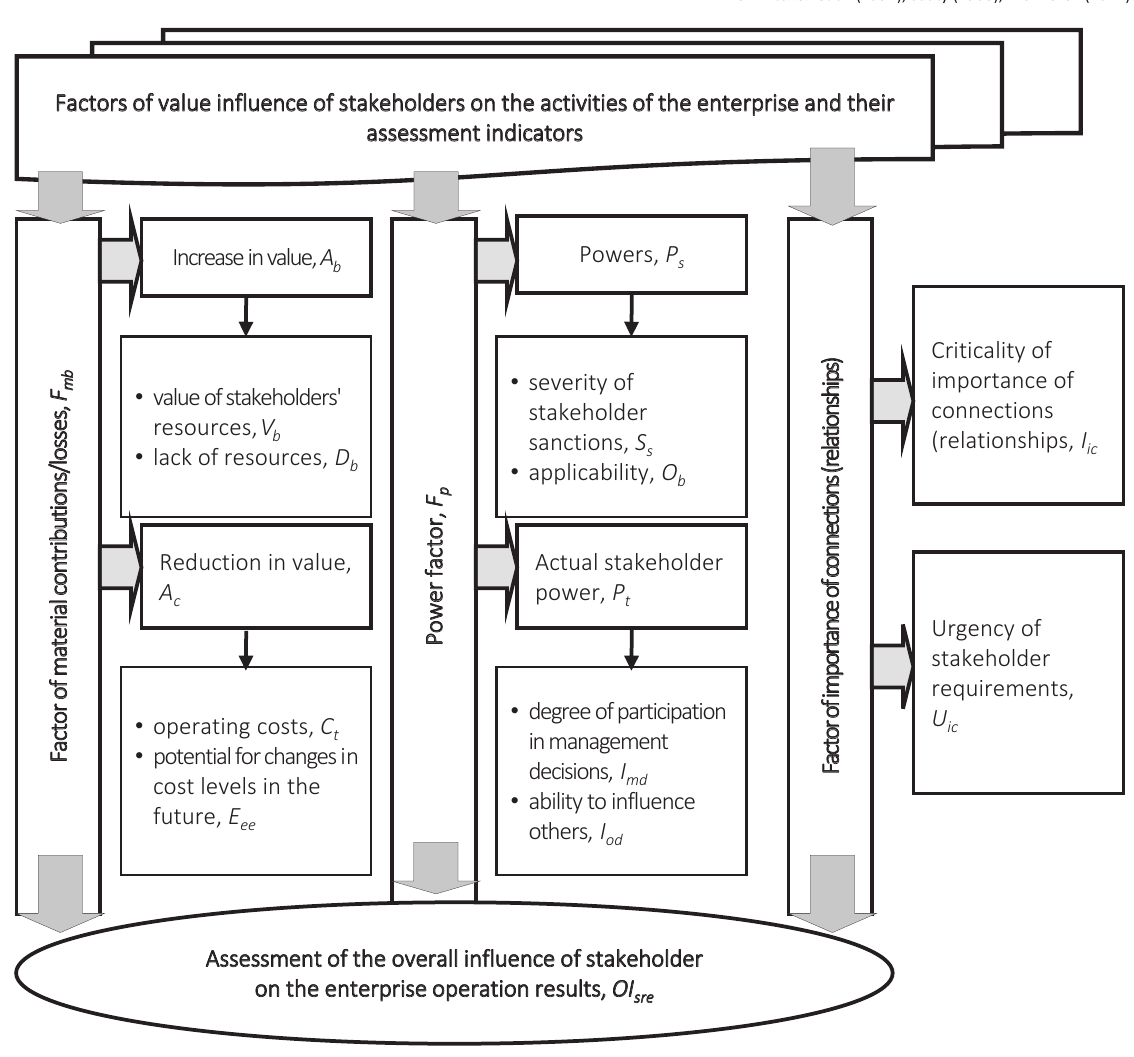
Figure 3. Value-based approach to stakeholder ranking based on hierarchy